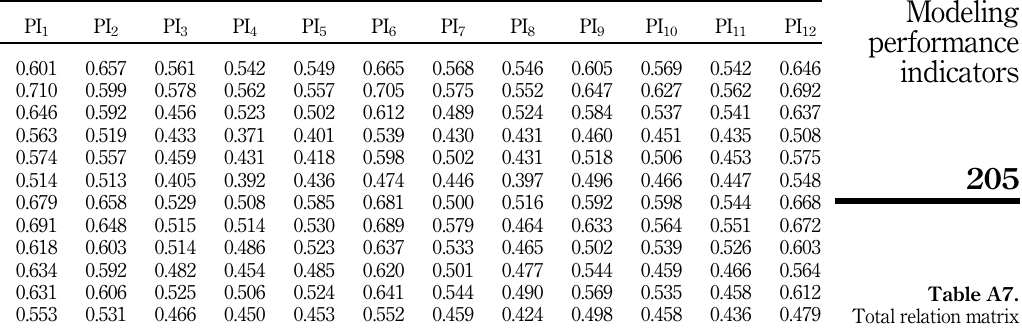
Table A7. Total relation